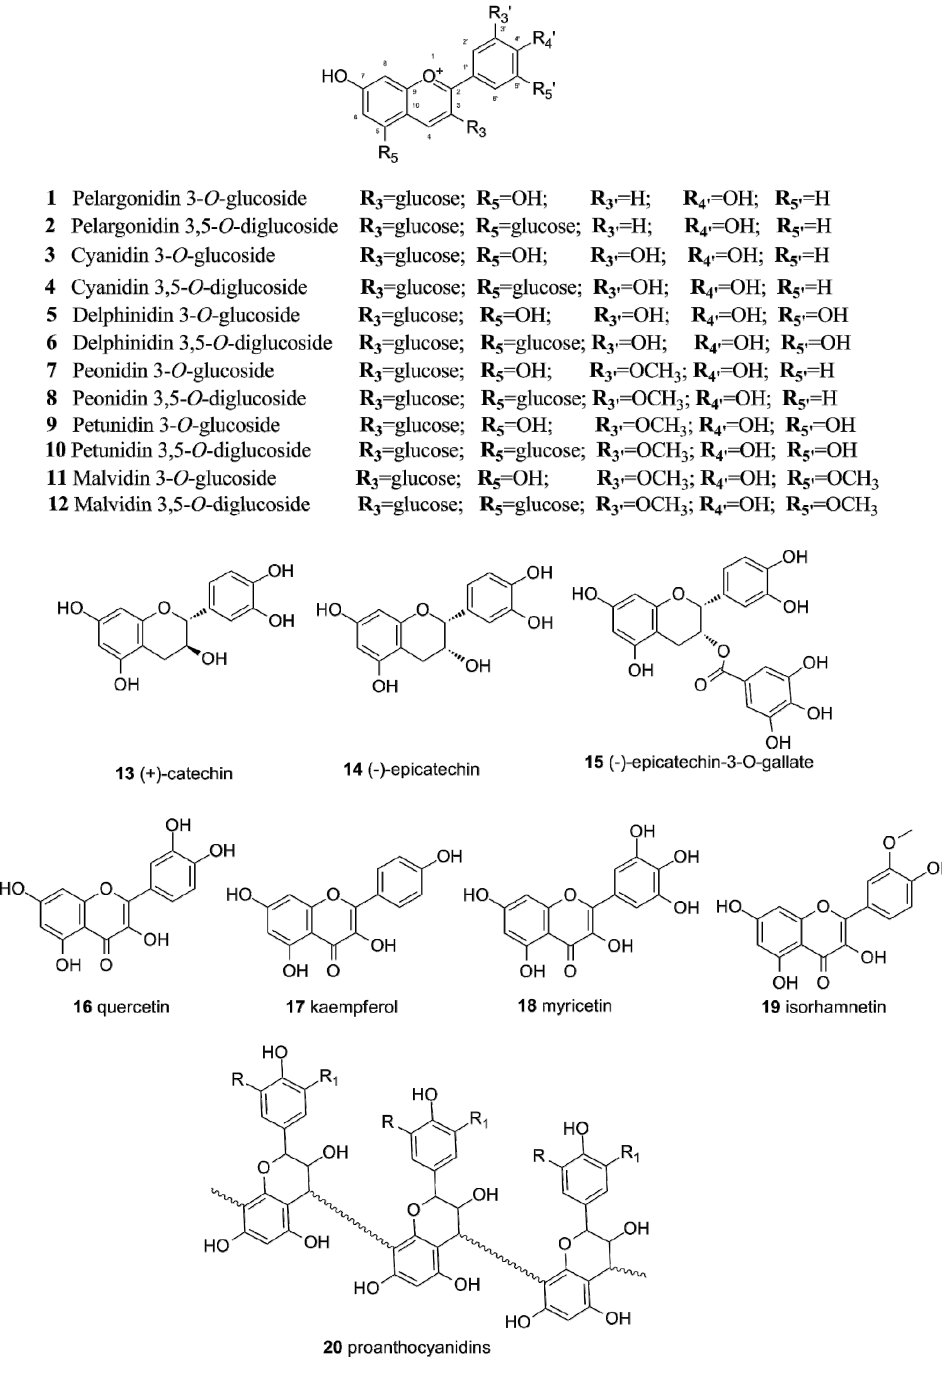
Figure 2. Structures of some common grape